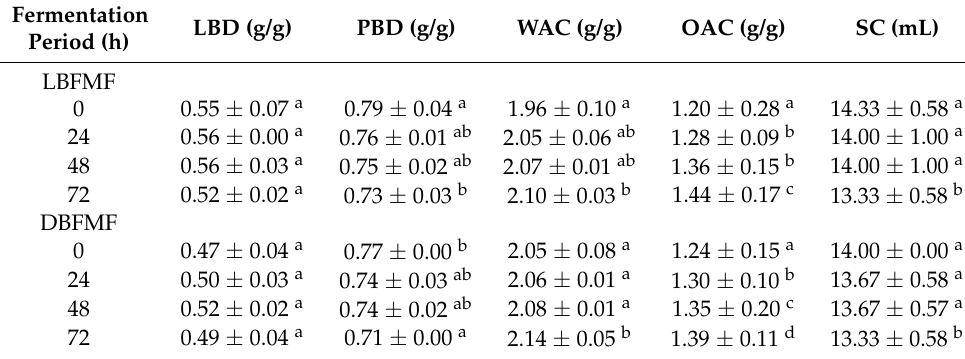
Table 2. Functional properties of spontaneously fermented finger millet